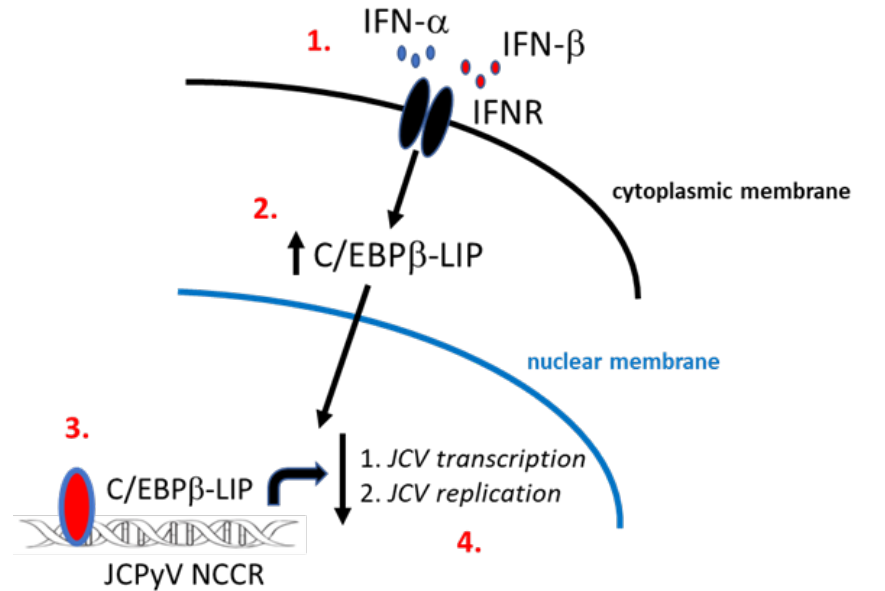
Figure 6. Schematic representation of a novel mechanism of JCPyV transcription and replication control by IFN α and IFN β by producing a dominate negative isoform LIP of C/EBP β . IFN α and β binding to IFN receptor (IFNR) activates the signaling pathway which leads to the formation of a phosphorylated STAT1 and STAT2 heterodimer complex to produce transcription factors which binds to IFN-stimulated response elements (ISREs) leading to the production of antiviral effectors [25] ( 1. ). Through these signaling pathways IFNs control viral replication, thus, viral spread through the induction of an antiviral state in infected and uninfected cells [26]. In addition to the JAK-STAT pathway, interferons have shown to exert their antiviral activity by modulating the function of some transcriptional factors such as C/EBP β families [15,27] ( 2. ). In this study, the dominant negative isoform LIP of C/EBP β has been shown to be stable in the nucleus after treatment with IFN α and β , and its interaction with the JCPyV NCCR [10] inhibits JCPyV life cycle ( 3. and 4. ). Supplementary Materials: The following are available online at https://www.mdpi.com/article/10.3390/v13101937/s1, Figure S1: Endogenous expression of the three c/EBP β isoforms (full length (FL), liver activating protein (LAP), and liver inhibitory protein (LIP)) after treatment with IFN α or IFN β ; Figure S2: MTT assay on luciferase assay in order to assess the possible cytotoxic effect of transient transfection and IFNs treatment on the assay outputs; Figure S3: MTT assay on the experiment performed to assess the effect of Adeno-siRNA-LIP on JCPyV-infected SVGA cells transiently transfected with C/EBP β -LIP expression plasmid, in presence or absence of IFN α or IFN β treatment, in order to assess the possible cytotoxic effect of transient transfection, IFNs treatment and viral infections on the assay